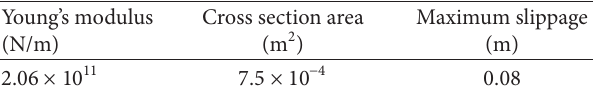
Table 1: Parameters of friction